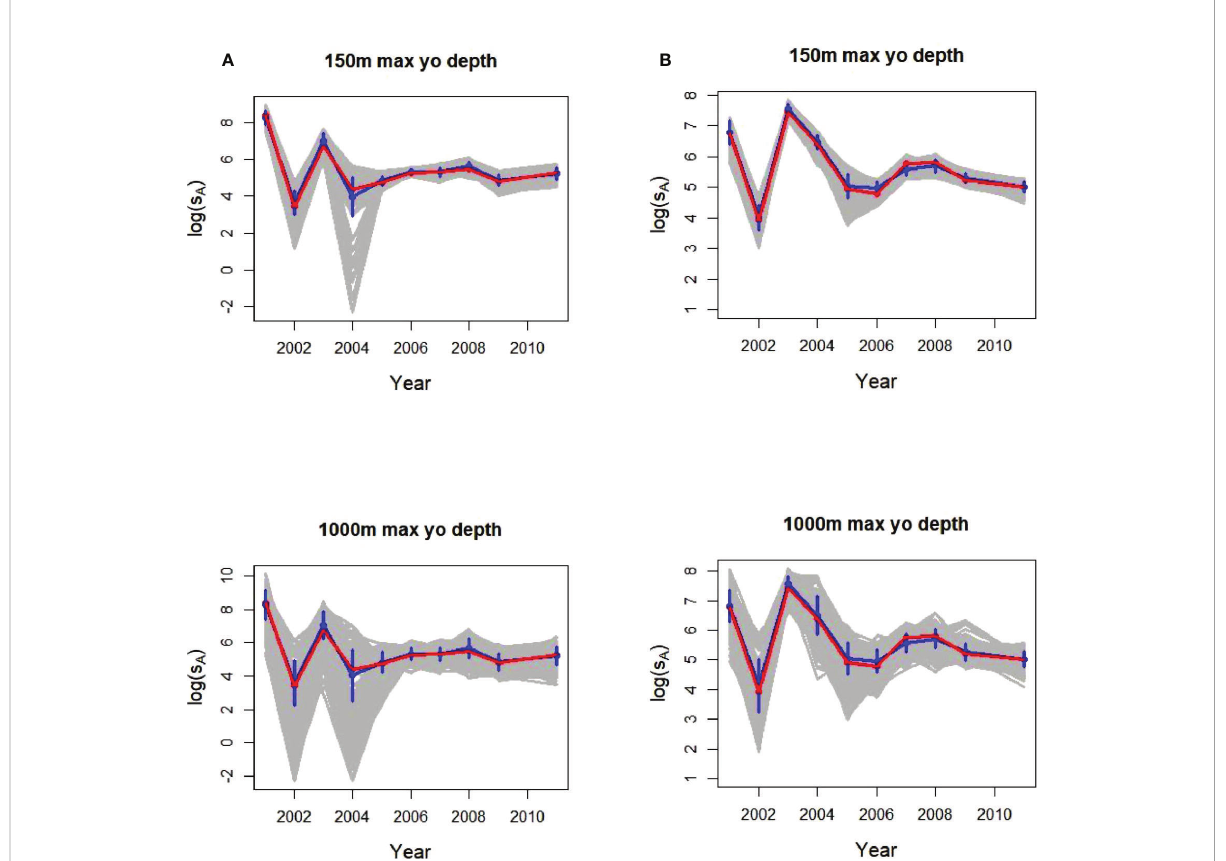
FIGURE 5 Annual glider logged sample means and SDs (blue) from 500 individual replicates (gray) of 1 glider with a maximum dive depths of 150 m (top plots) and 1000 m (bottom) sampling acoustic energy (s A ) in (A) Brans fi eld Strait and (B) Cape Shirreff. In all plots, the population means being sampled (from the original ship surveys) are in